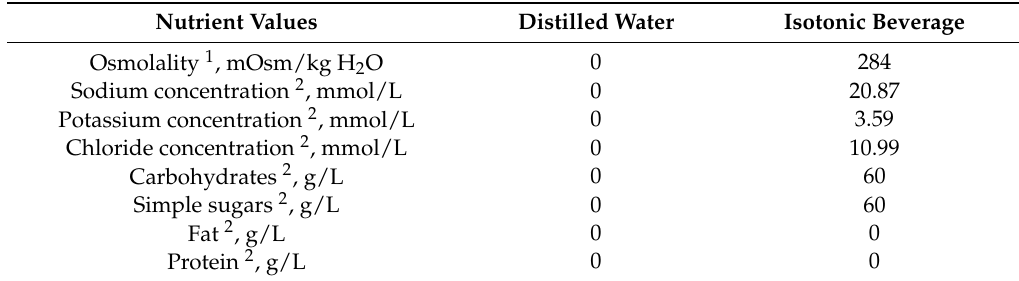
Table 2. Composition of distilled water and isotonic